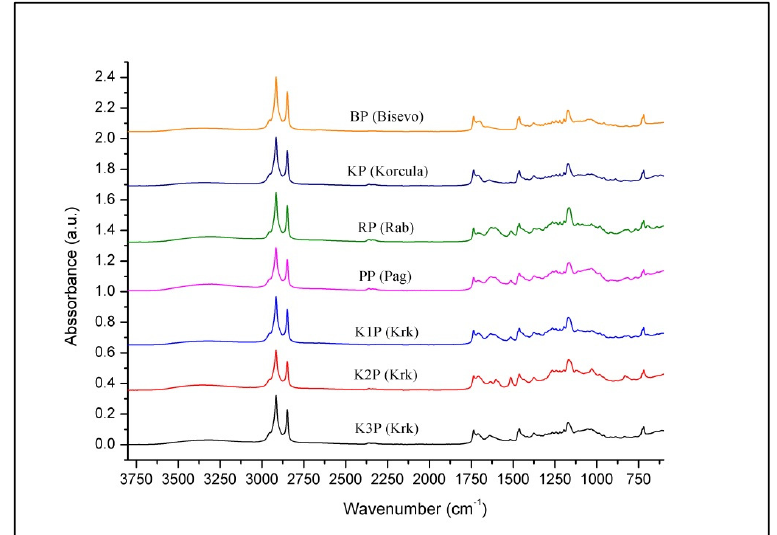
Figure 2. Average FTIR ATR spectrum of investigated propolis collected from five Adriatic Sea islands (Krk, Rab, Pag, Biševo and Kor č ula).